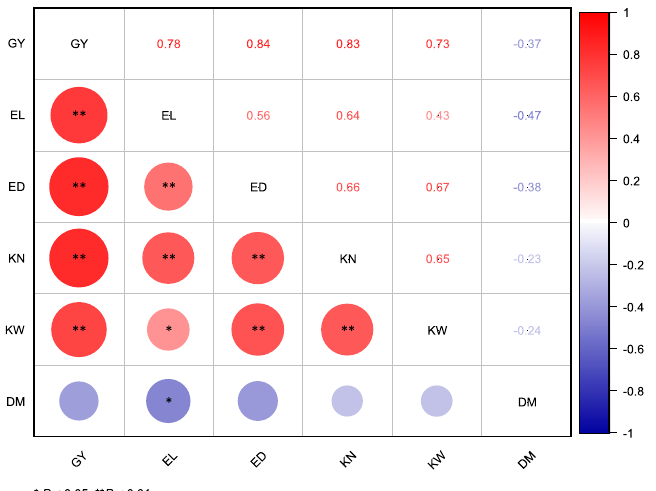
Figure 5. Correlation analysis of grain yield (GY), ear length (EL), ear diameter (ED), kernel number per ear (KN), 100-kernel weight (KW), and dry matter yield (DM). Correlation values show in the upper triangular, significant mark show in the lower triangular, and * and ** show significant difference at the 0.05 and 0.01 probability levels, respectively. Graph was created using Origin software version 2021 (Origin Lab